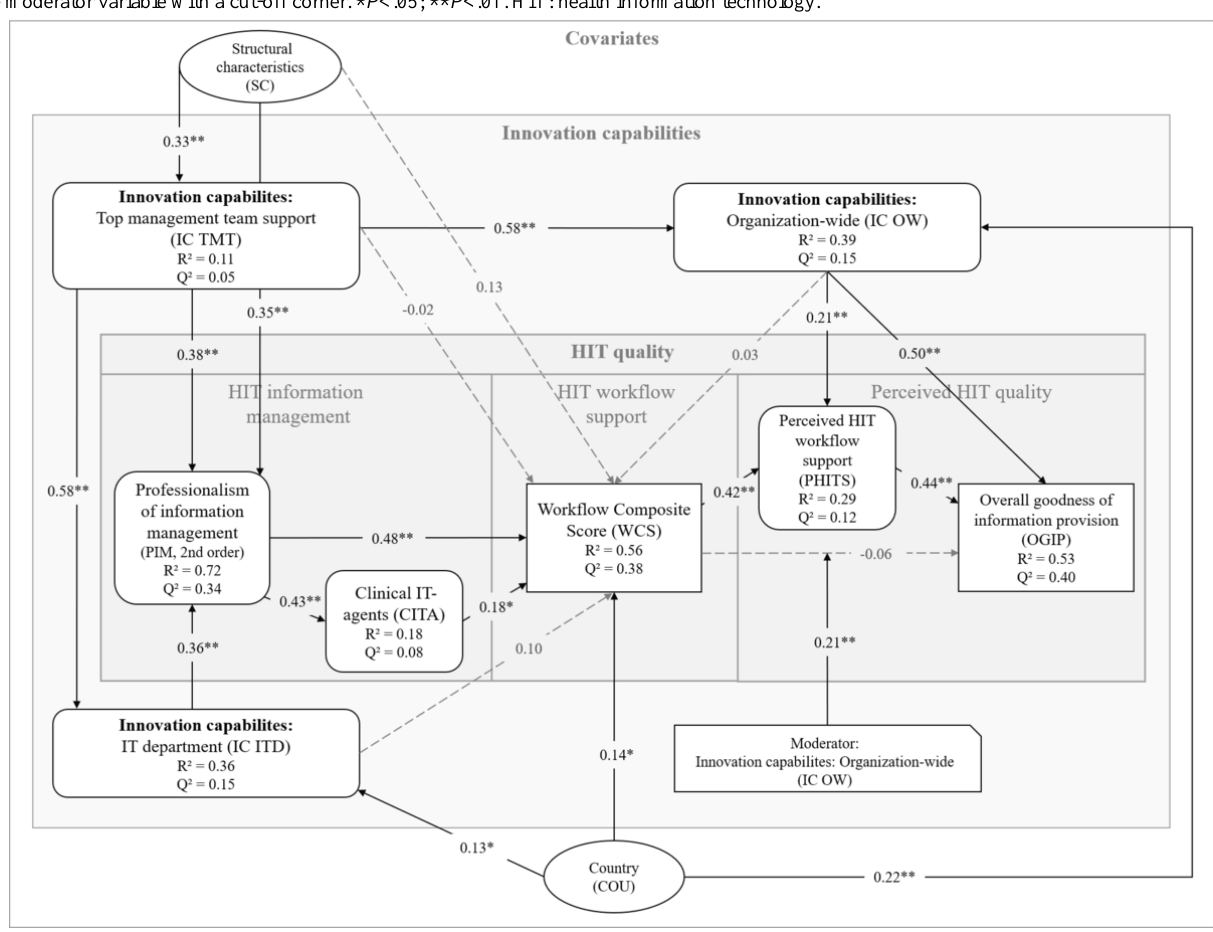
Figure 2. The structural model of innovation and quality of health information technology with path coefficients, explained variance (R²), and predictive relevance measures (Q²) of the endogenous constructs. Latent constructs are displayed with rounded edges, the exogenous covariates as ellipses and the moderator variable with a cut-off corner. * P <.05; ** P <.01. HIT: health information